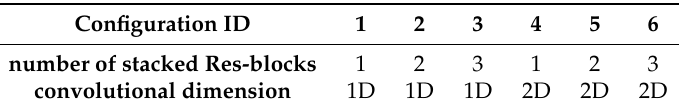
Table 3. ResNet configuration sets.